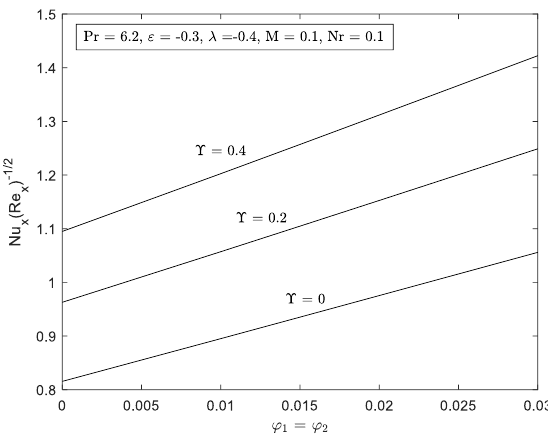
1 1 1 − 1 2 for several ϒ with 𝜑 1 = 𝜑 2 . 2 for several ϒ with 𝜑 1 = 𝜑 2 . 2 for several Υ with ϕ 1 = ϕ 2 2 for several ϒ with 𝜑 1 = 𝜑 2 . Figure 13. Nu x ( Re x )